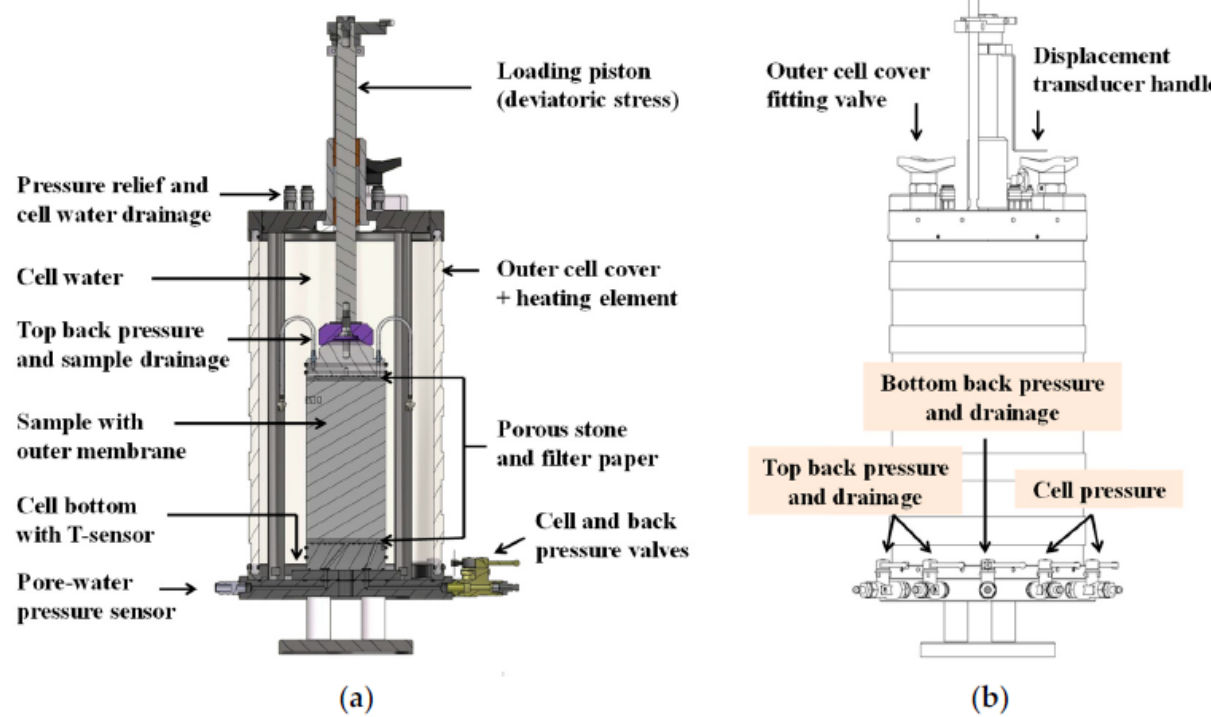
Figure 6. Schematic representations of the triaxial cell used in the study (sample size not to scale): ( a ) inner sectional view; ( b ) front